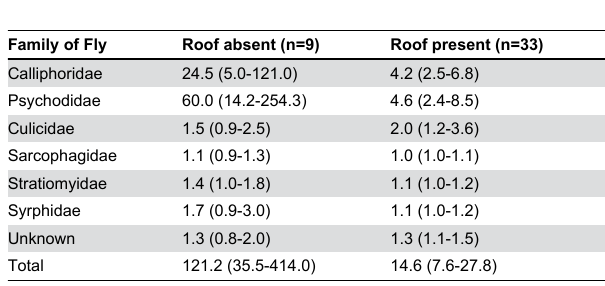
Table 4. Geometric means (95% confidence intervals) for families of flies when roof is absent and present.